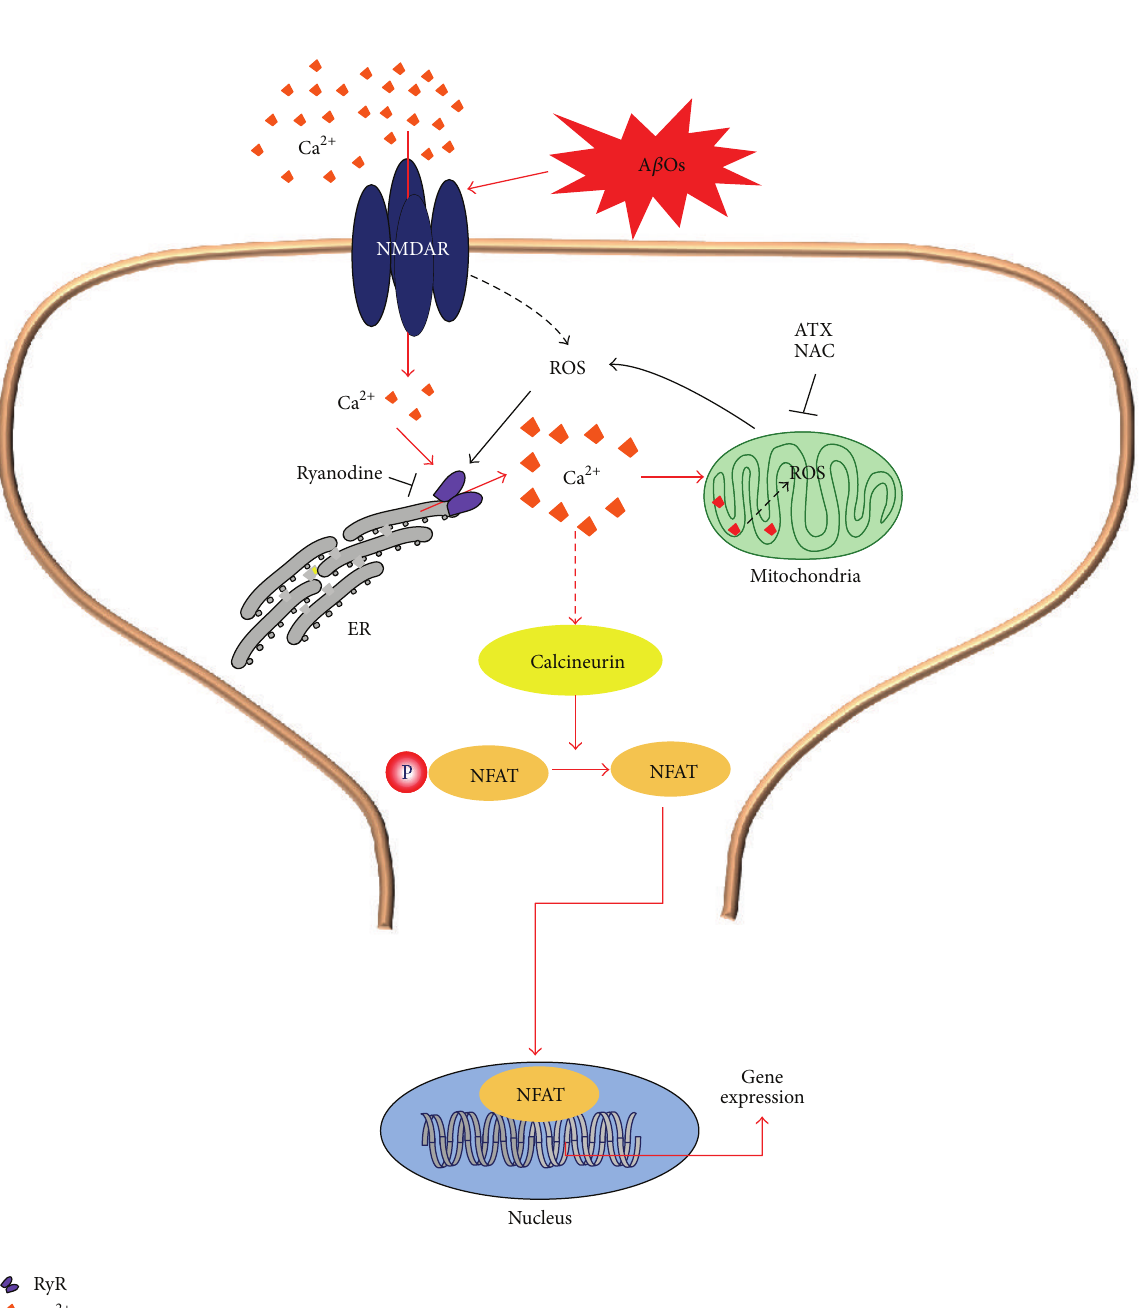
Figure 5: Scheme showing a possible mechanism to explain ATX neuroprotection over the deleterious effects of A 𝛽 Os. A 𝛽 Os promote increased ROS generation and induce abnormal Ca 2+ signals in primary hippocampal neurons, which arise initially from Ca 2+ entry through NMDAreceptors;theseentrysignalsaresubsequentlyamplifiedbyCa 2+ releasethroughRyRchannelscostimulatedbyCa 2+ andtheincreased ROS levels generated response to A 𝛽 Os [25]. Activation of RyR-mediated Ca 2+ release by ROS [59, 77] induces mitochondrial Ca 2+ -uptake, which is prevented by ryanodine at inhibitory concentrations [27]. These abnormal cytoplasmic Ca +2 signals promote NFATc4 translocation, which induces deleterious changes in gene expression and dendritic spine morphology [42]. ATX and NAC, either by scavenging ROS/RNS or by increasing antioxidant defenses, would prevent abnormal A 𝛽 Os induced RyR-mediated Ca 2+ -induced Ca 2+ release and thus would prevent the harmful effects of enhanced NFAT nuclear